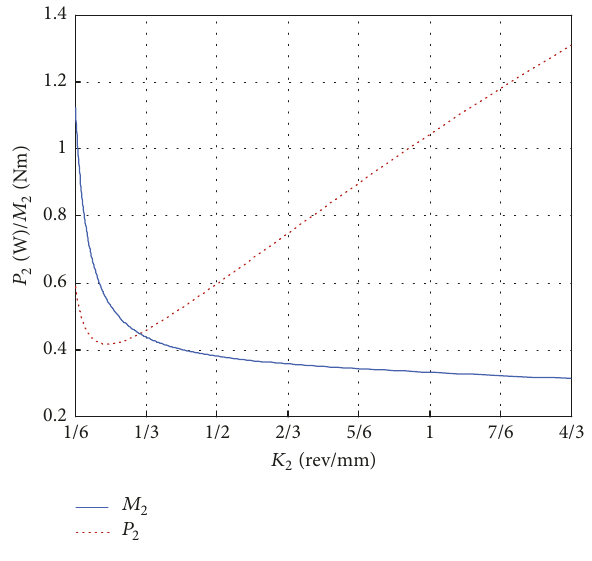
Figure 16: 𝑀 2 and 𝑃 2 versus 𝐾 2